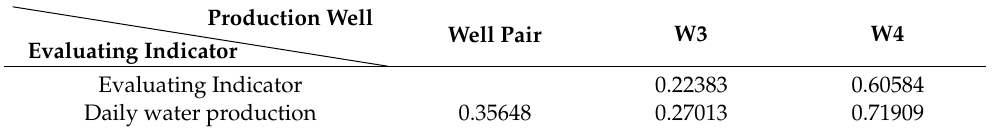
Table 3. The injection–production response characteristics of A well group.